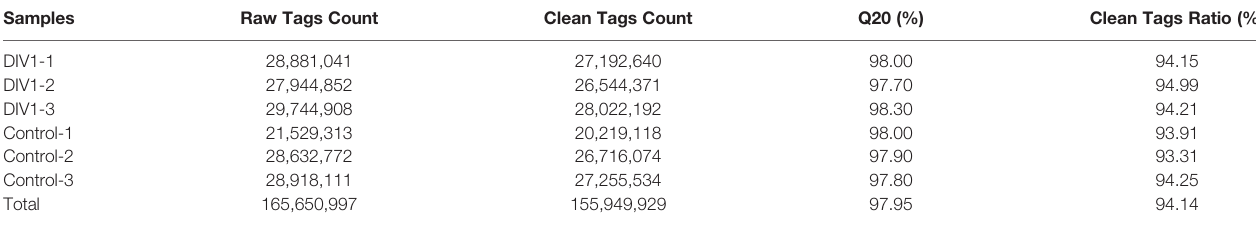
TABLE 3 | Summary of miRNA-seq